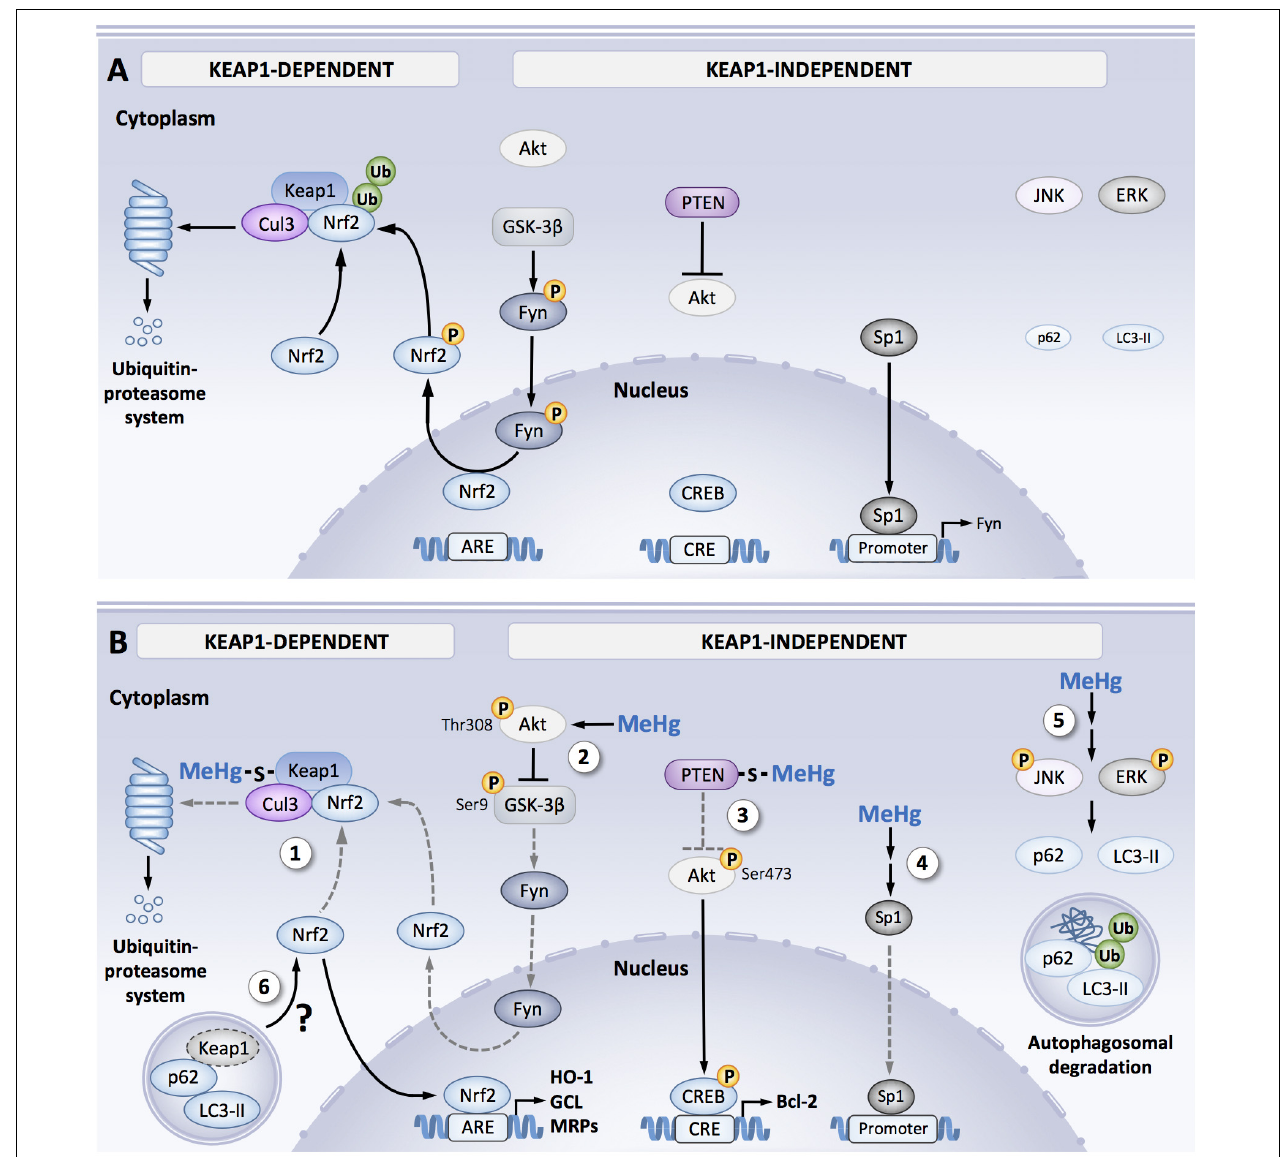
FIGURE 1 | Signal orchestration against MeHg toxicity. (A) Under non-stressed conditions, Nrf2 is captured by Keap1 and ubiquitinated by Cul3 in the cytosol that leads to degradation through ubiquitin–proteasome system, resulting in the inhibition of Nrf2 translocation from the cytoplasm to nucleus. Fyn is phosphorylated by GSK-3 β , leading to Fyn nuclear localization. Fyn phosphorylates nuclear Nrf2, which leads to nuclear export and degradation of Nrf2. Sp1 is a transcription factor of Fyn. Steady state level of p62 and LC3-II expression under basal activity of JNK and ERK. (B) Cellular protective responses to MeHg. MeHg covalently modifies Keap1 through Cys151 and/or Cys319, leading to inhibition of Nrf2 degradation. As a result, Nrf2 translocates into nucleus and the interacts with a partner protein sMaf, resulting in formation of heterodimer that binds to the antioxidant response element (ARE), thereby upregulating its downstream genes (e.g., HO-1, GCL, and MRP) (1). MeHg induces phosphorylation of GSK-3 β at Ser9 mediated by activated Akt at Thr308. Since this inactive form of GSK-3 β is unable to phosphorylate Fyn, substantial retain of nuclear Nrf2 coupled to diminished nuclear translocation of Fyn occurs (2). MeHg covalently modifies PTEN, resulting in inhibition of its catalytic activity, thereby phosphorylating Akt through Thr473 and tits downstream transcription factor CREB, which binds to the cAMP-response element (CRE), leading to up-regulation of anti-apoptotic protein Bcl-2 (3). MeHg reduces Sp1 protein level and thus down-regulates Sp1-dependent target genes such as fyn (4). Phosphorylation of JNK and ERK mediated by MeHg increases p62 and LC3-II expressions, thereby promotes autophagosomal degradation of misfolded/damaged proteins (5). Possible linkage between MeHg-induced MAPK activation and Nrf2 upregulation via p62/LC3-II-mediated autophagosomal degradation of Keap1 (6). Dotted gray lines indicate processes disrupted by MeHg